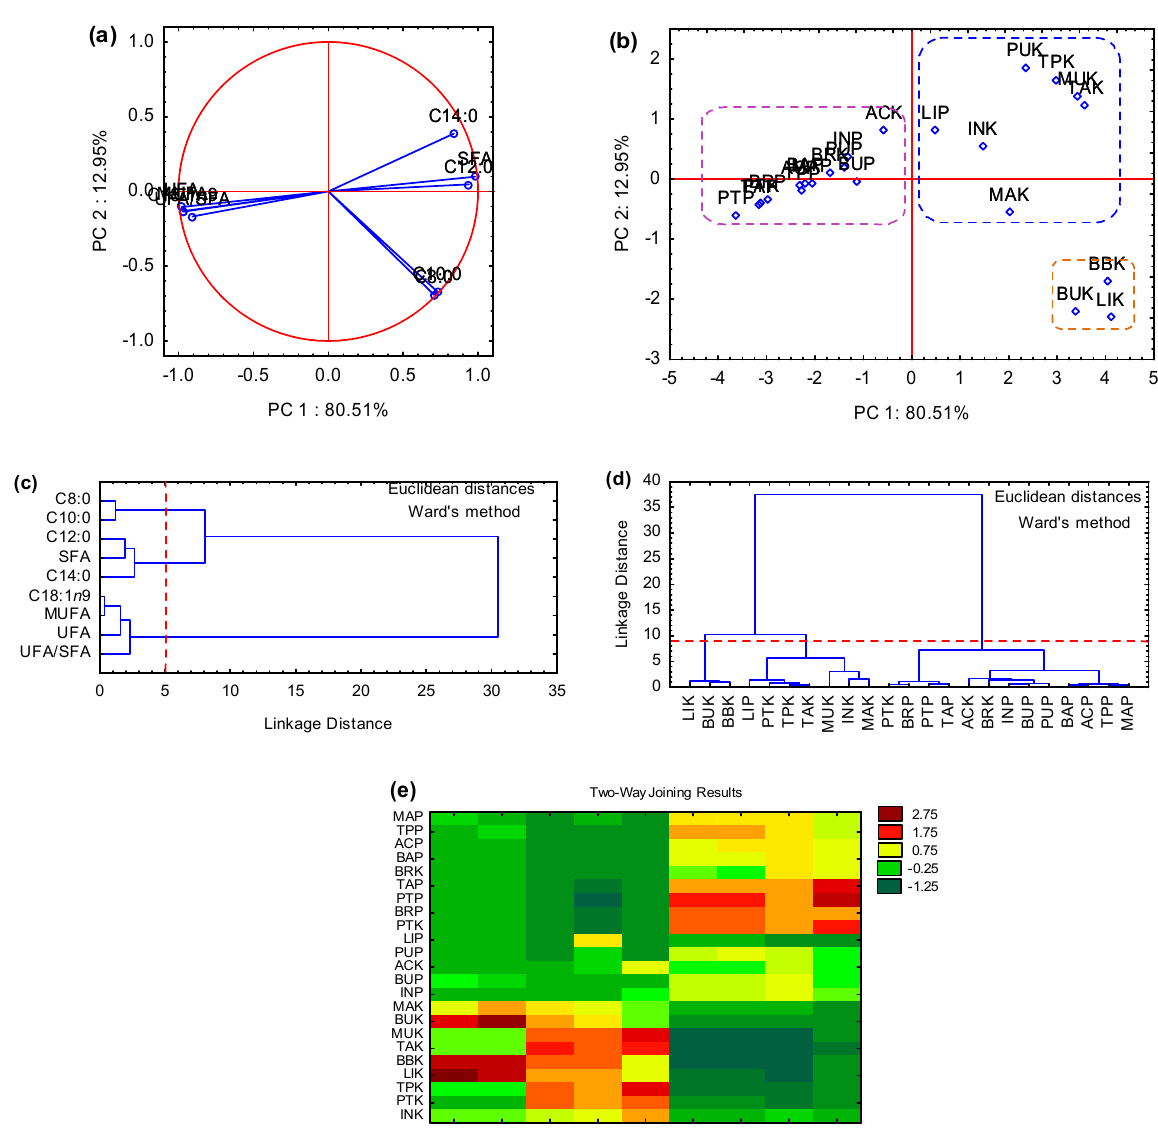
Figure 7. Principal component analysis (PCA) and hierarchical cluster analysis (HCA) of Arecaceae palm fruit oils based on their fatty acid profile. Loading plot for principal component 1 × principal component 2 with the projection of variables ( a ) and score plot of oil samples ( b ); clustering and linkage distance of variables ( c ) and oil samples ( d ) from HCA based on Ward’s method; and the heatmap showing the similarities and differences among oils according to the main significant variables ( e ). Refer to Table 1 for samples’ acronyms.